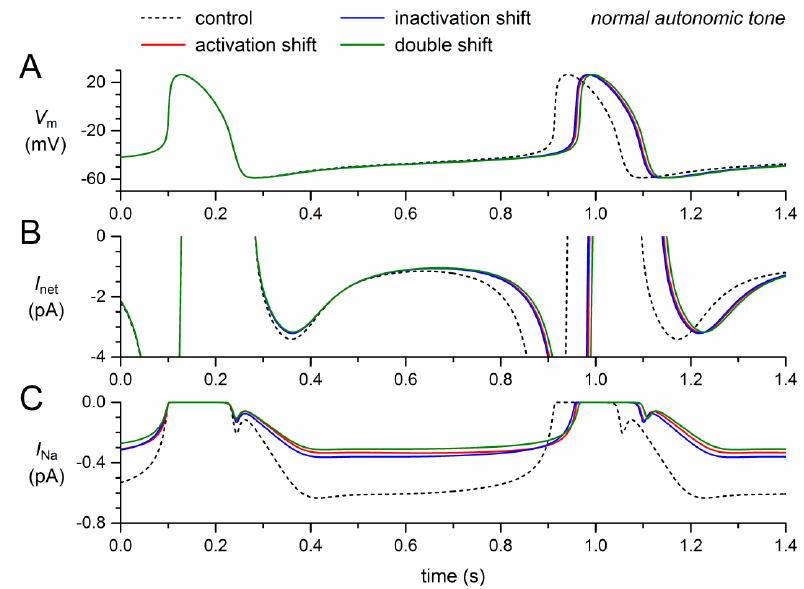
Figure 2. Effect of a +8.1 mV shift in steady-state activation and a −7.3 mV shift in steady-state inactivation as observed for the 1795insD mutation in SCN5A on the electrical activity of the Fabbri – Severi model cell at normal beating rate (normal autonomic tone). ( A ) Membrane potential ( V m ). ( B ) Net membrane current ( I net ). ( C ) Fast sodium current ( I Na ). Effect of the shift in steady-state activation per se (red traces), the shift in steady-state inactivation per se (blue traces), and the combined effect (green traces). Note the difference in ordinate scales between panels B and C. In the model, I Na is split Table 2. Effects on action potential configuration.